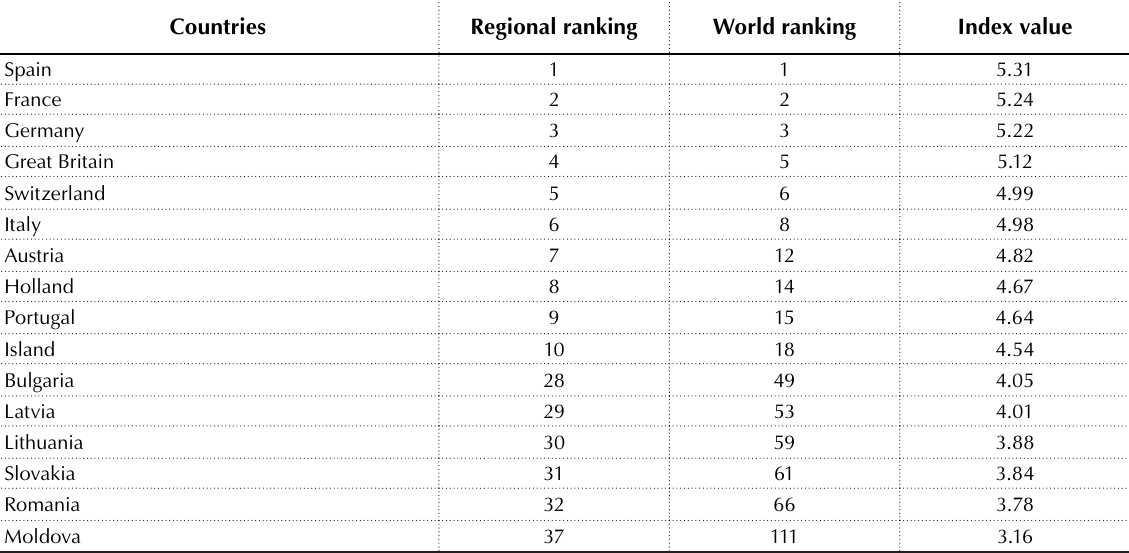
Table 1. Tourism industry Competitiveness Index: European Region,